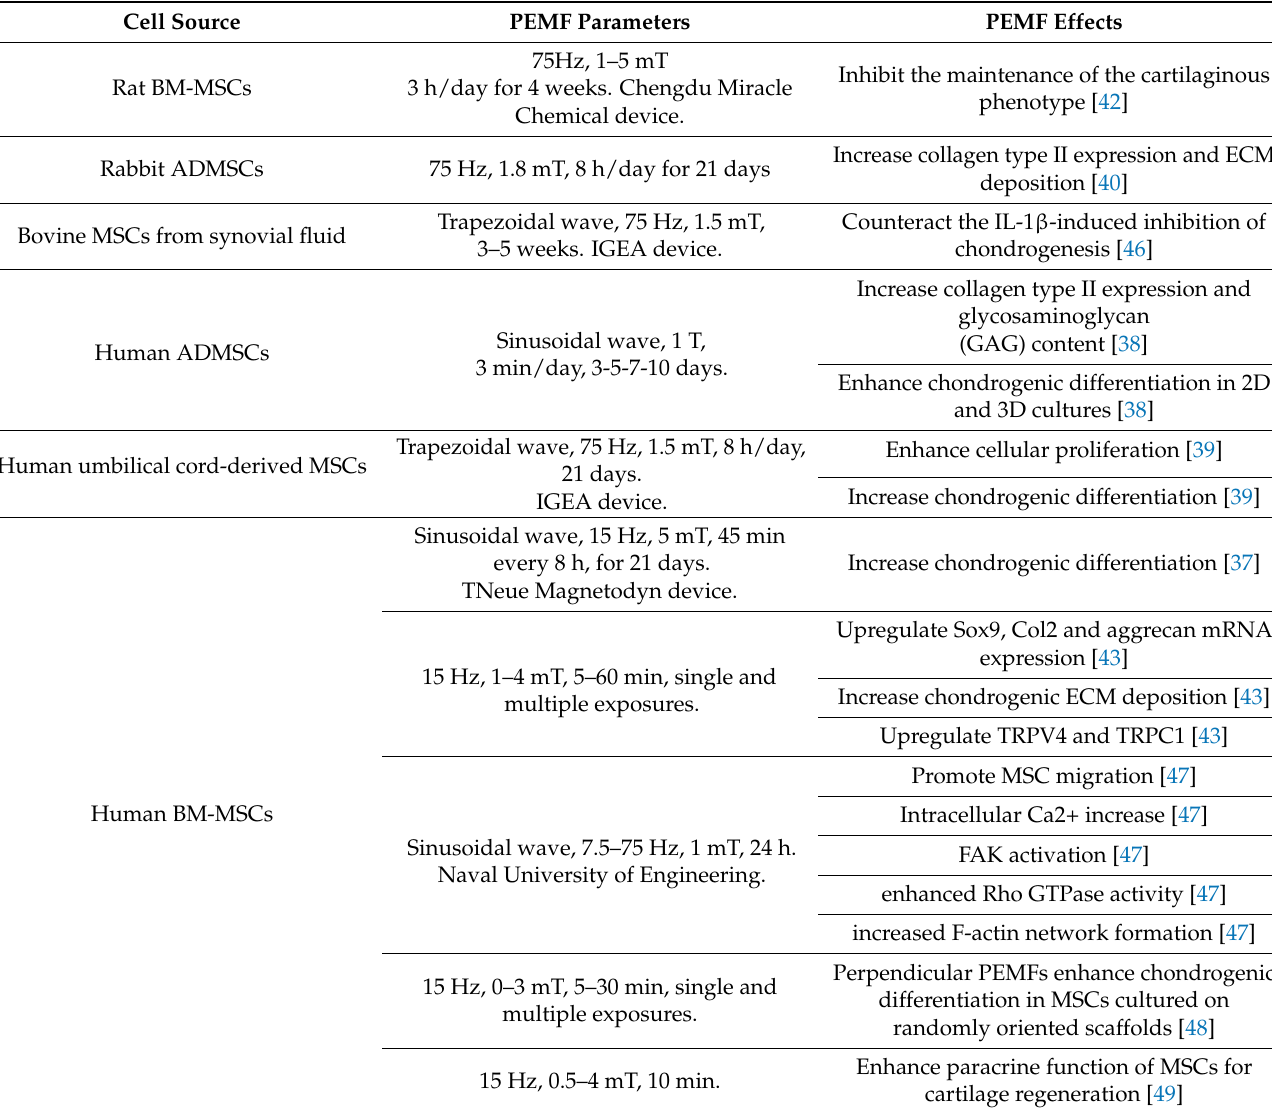
Table 1. Effects of pulsed electromagnetic fields on the chondrogenic potential of mesenchymal stem cells (MSCs). Cell